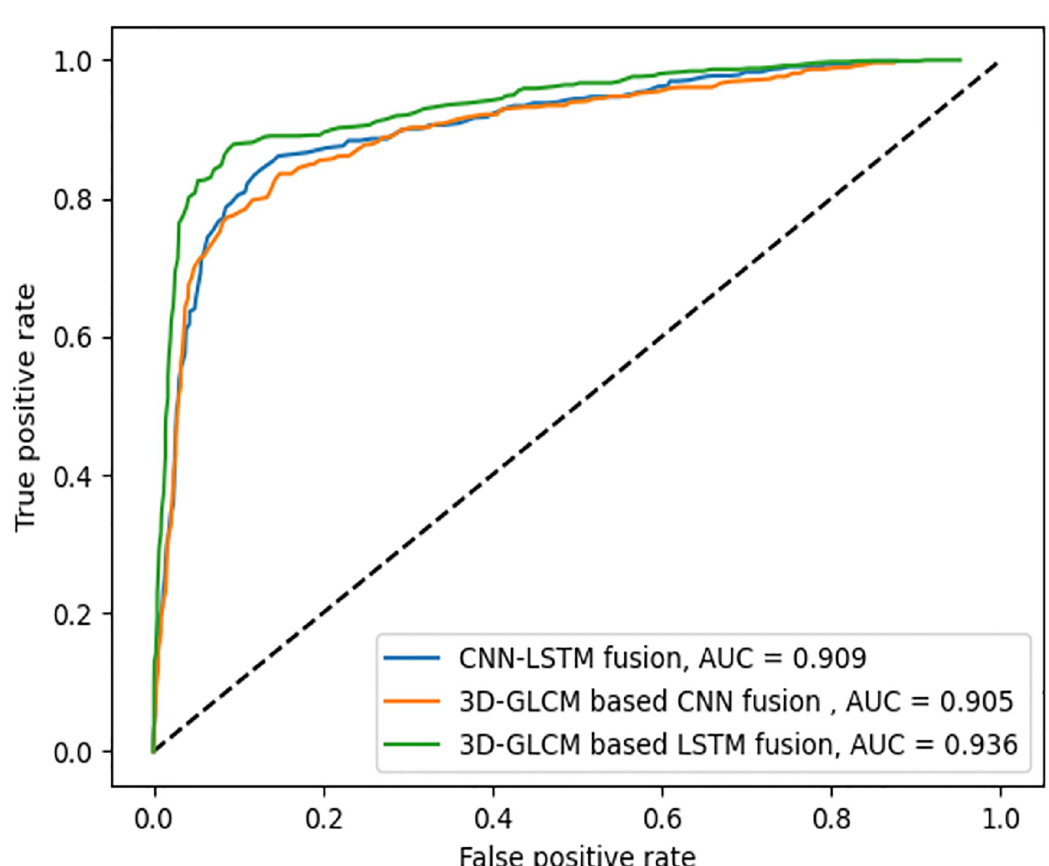
Fig 10. ROC curves for baseline and proposed models, and their corresponding macro-averaged AUC values.